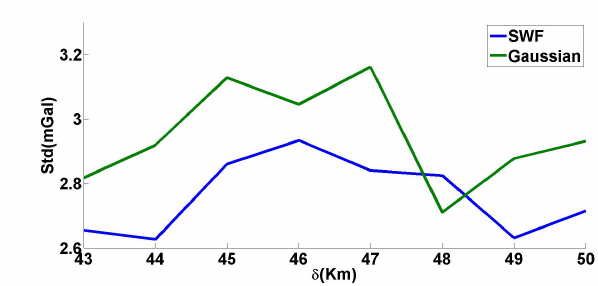
Table 1. Statistical analysis of the differences between SIMLS inter- polated values and those from shipborne gravimetry, in mGal unit, 25 harmonic basis